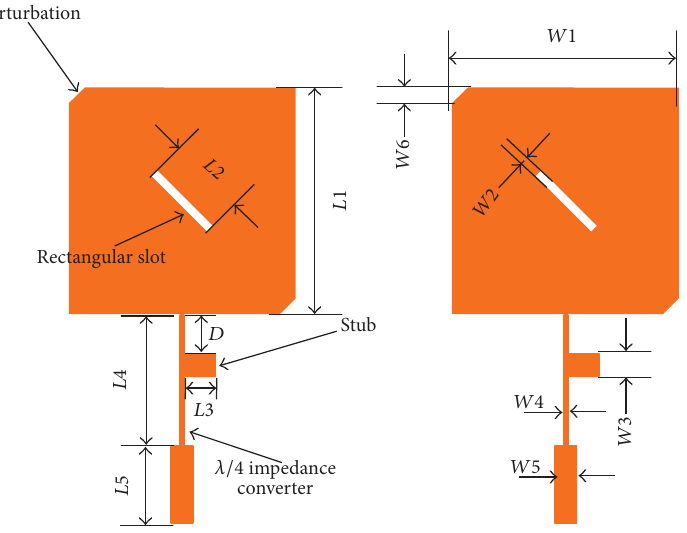
Figure 1: The layout of antenna part of proposed rectenna.